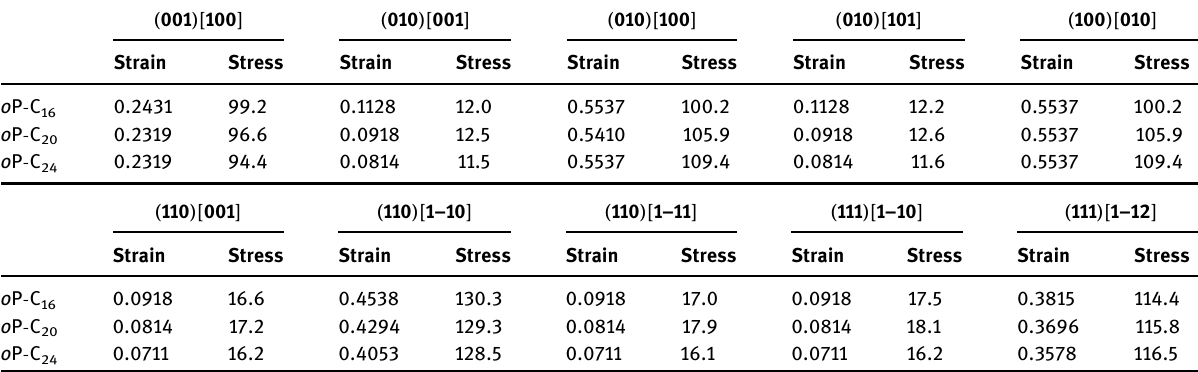
Table 3: Obtained ideal shear strengths for o P - C 16 , o P - C 20 , and o P - C 24 with the corresponding strains that produce the maximum stress ( GPa